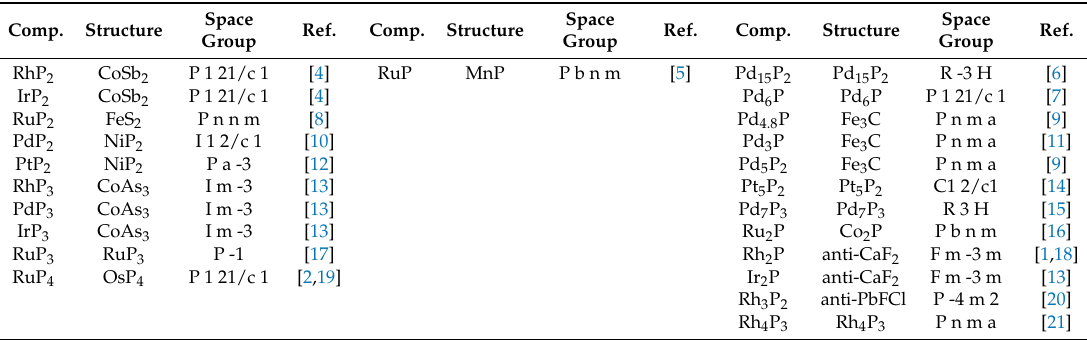
Table 1. Overview of the 23 reported binary phosphides, their 16 different structures, and the corresponding space groups of the platinum group metal (PGM) phosphides [1]. Comp.